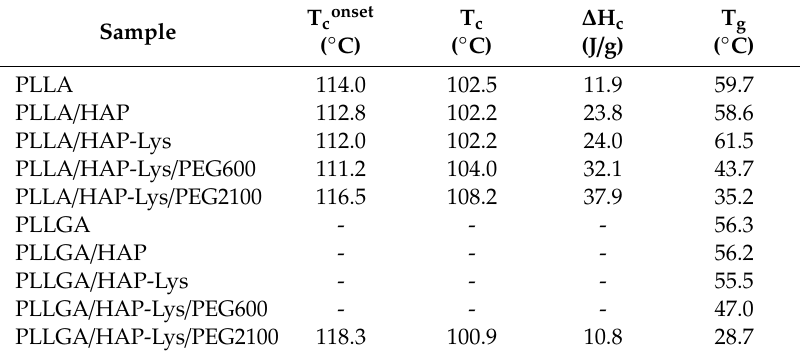
Table 2. Thermal Parameters from the Cooling DSC Curves of PLLA and PLLGA Sample Series. T Sample